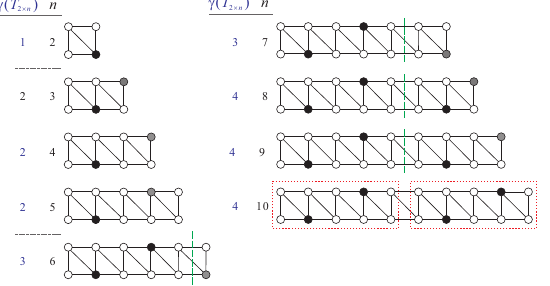
(cid:101) for 2 (cid:54) n (cid:54) 10; filled circles indicate vertices in the 5